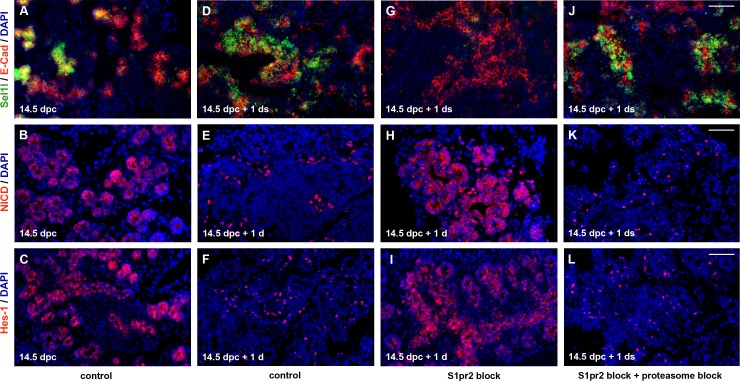
S1pr2 signalling attenuates Notch signalling.(A-F) Immunofluorescence analysis showed that Sel1l is strongly expressed in 14.5 dpc pancreata maintained for 1 d (14.5 dpc + 1 d) in ALI cultures compared to 14.5 dpc pancreata (A, D), and this correlated with a drop in the expression levels of NICD (B, E) and Hes1 (C, F). (G-I) S1pr2 signalling block with 15 μM JTE013 in 14.5 dpc + 1 d ALI cultures resulted in loss of Sel1l expression (G), concomitant with maintenance of high NICD (H) and Hes1 (I) expression. (J-L) Sel1l expression was restored in the absence of S1pr2 signalling by 1 μM of the specific proteasome inhibitor MG132 in 14.5 dpc + 1 d ALI cultures (J), and this was sufficient to restore attenuation of both NICD (K) and Hes1 (L) expression. Scale bars, 50μm (A-L). For raw data, please refer to the S1 Data file.